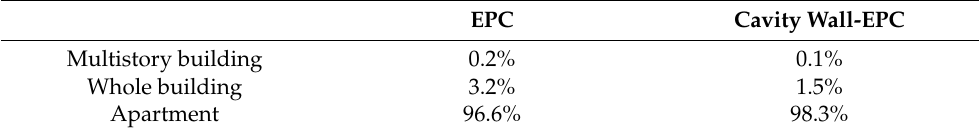
Table 11. EPC distribution by building type.